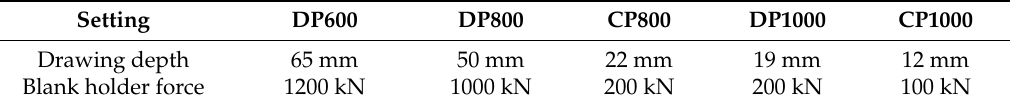
Figure A3. Initial blank geometry for cross-die samples. Table A9. Drawing depths without failure (necking or fracture) of cross-die samples. Table A8. Influence of grinding and polishing steps on the example of DP600.